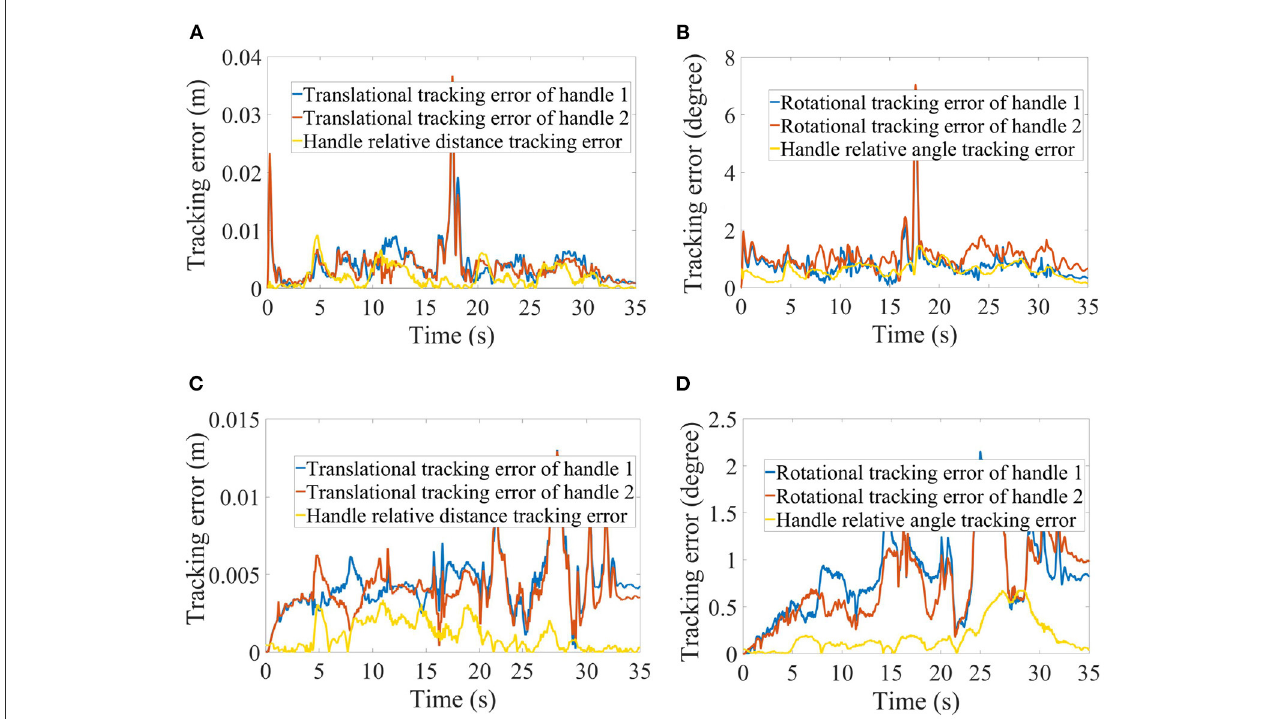
FIGURE7 Translational tracking errors of the two handles and the relative distance between them in scenario 1 (A) and scenario 2 (C) , and rotational tracking errors of the two handles and the relative angle between them in scenario 1 (B) and scenario 2 (D) , respectively.